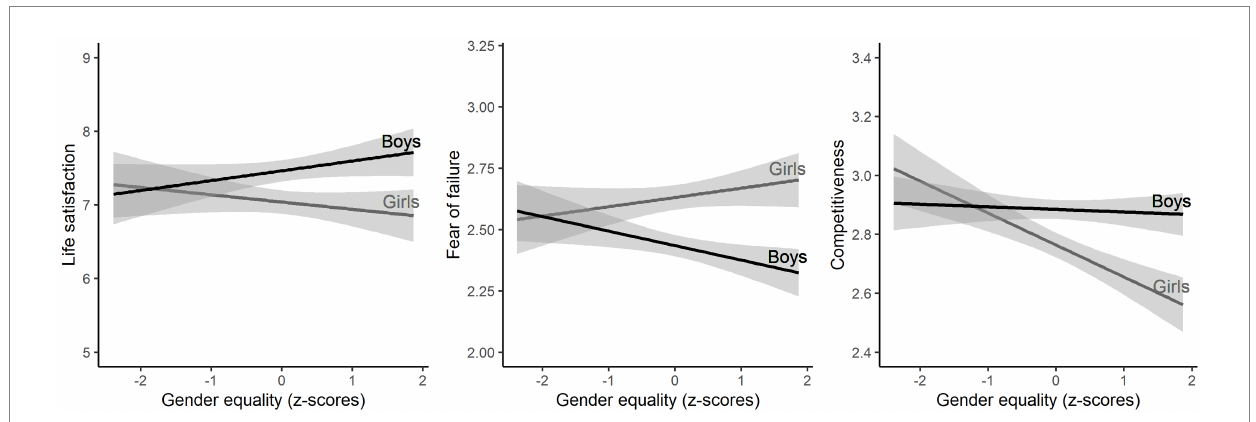
FIGURE 2 Estimated linear relations between the WVS measure of gender equality of a country and boys’ and girls’ average life satisfaction (left), average fear of failure (middle), and average competitiveness (right). Shaded areas indicate 95% confidence intervals of the regression